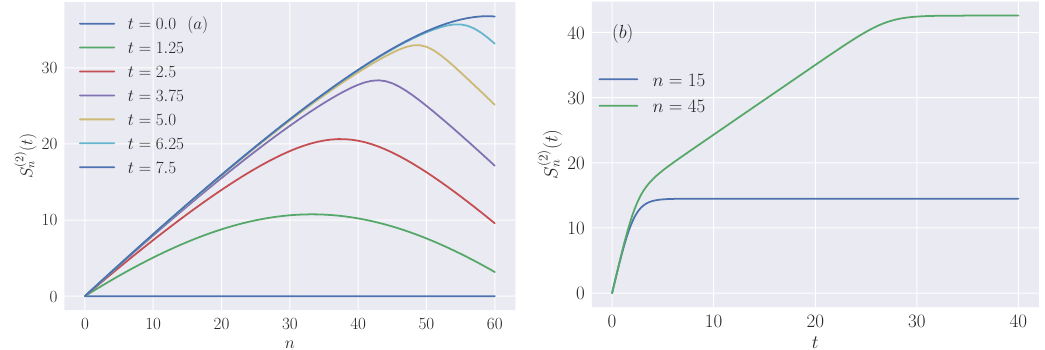
Figure 3 . R(cid:19)enyi entropy dynamics for di(cid:11)erent subsystems, obtained by solving eq. (3.19), for local dimension d = 2 and N = 60. Sub(cid:12)gure ( a ): R(cid:19)enyi-2 entropy S (2) n ( t ) as a function of